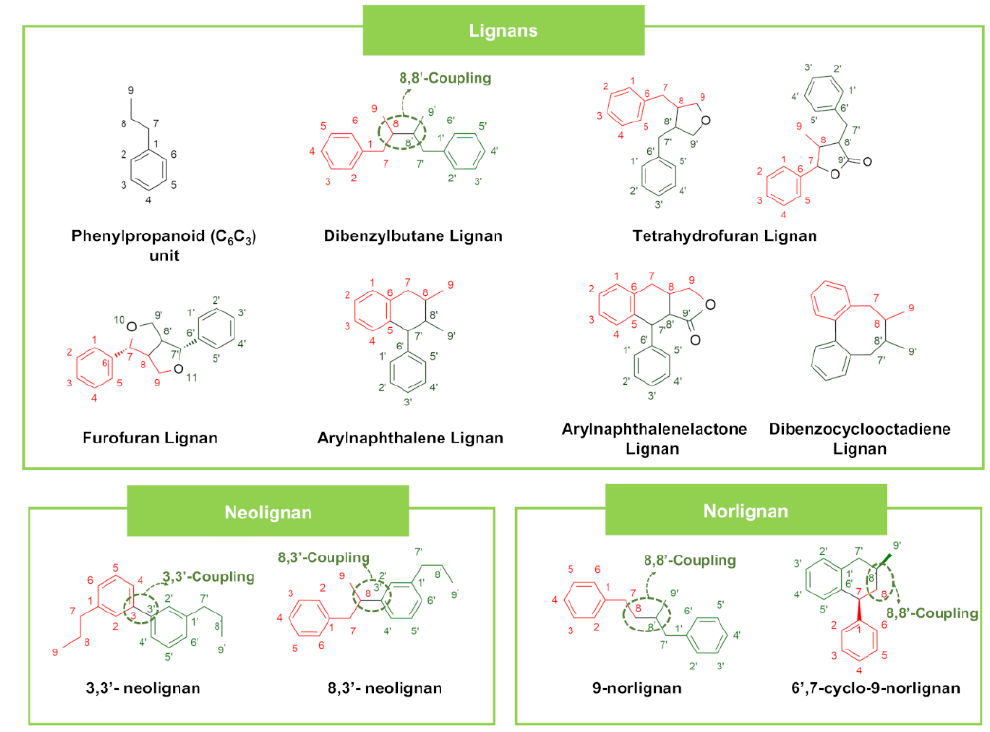
Figure 6. Representative chemical structures of different lignan types and lignan subclasses.